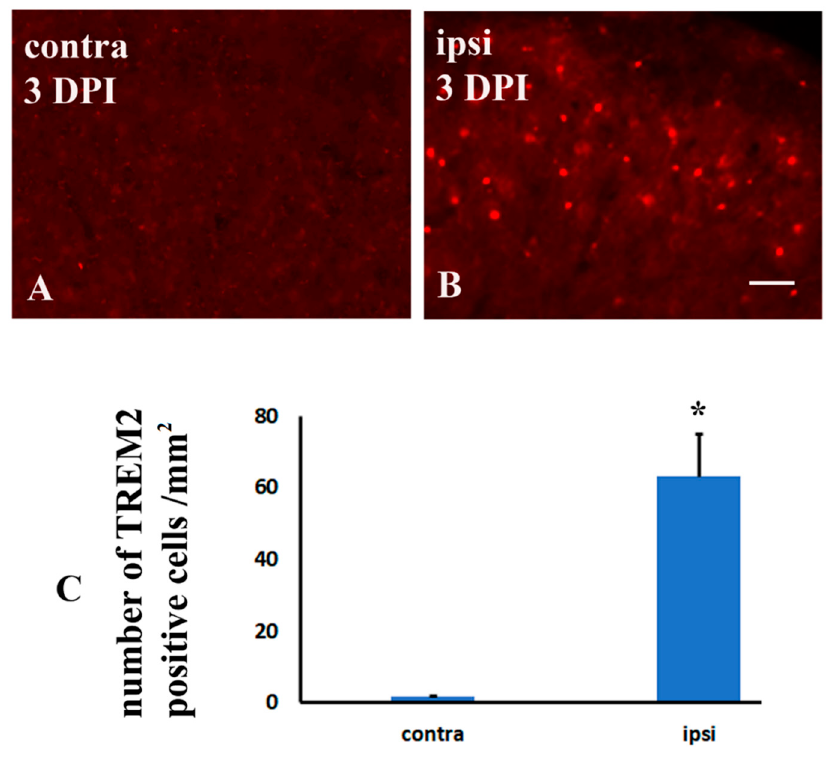
Figure 9. Immunohistochemistry for TREM2 in the dorsal horns of the spinal cord following nerve ligation of brachial plexus in non-TgCRND8 mice. ( A ): TREM2 expression of the contralateral side (contra) at 3 days following nerve ligation (DPI). ( B ): TREM2 expression of the ipsilateral sides (ipsi) at 3 days after nerve ligation (DPI). ( C ): Comparison in the TREM2 expression at 3 days after nerve ligation between the contralateral and ipsilateral side of the dorsal horn. * Significant differences between the two sides, p < 0.001. Scale bar, 50 µ